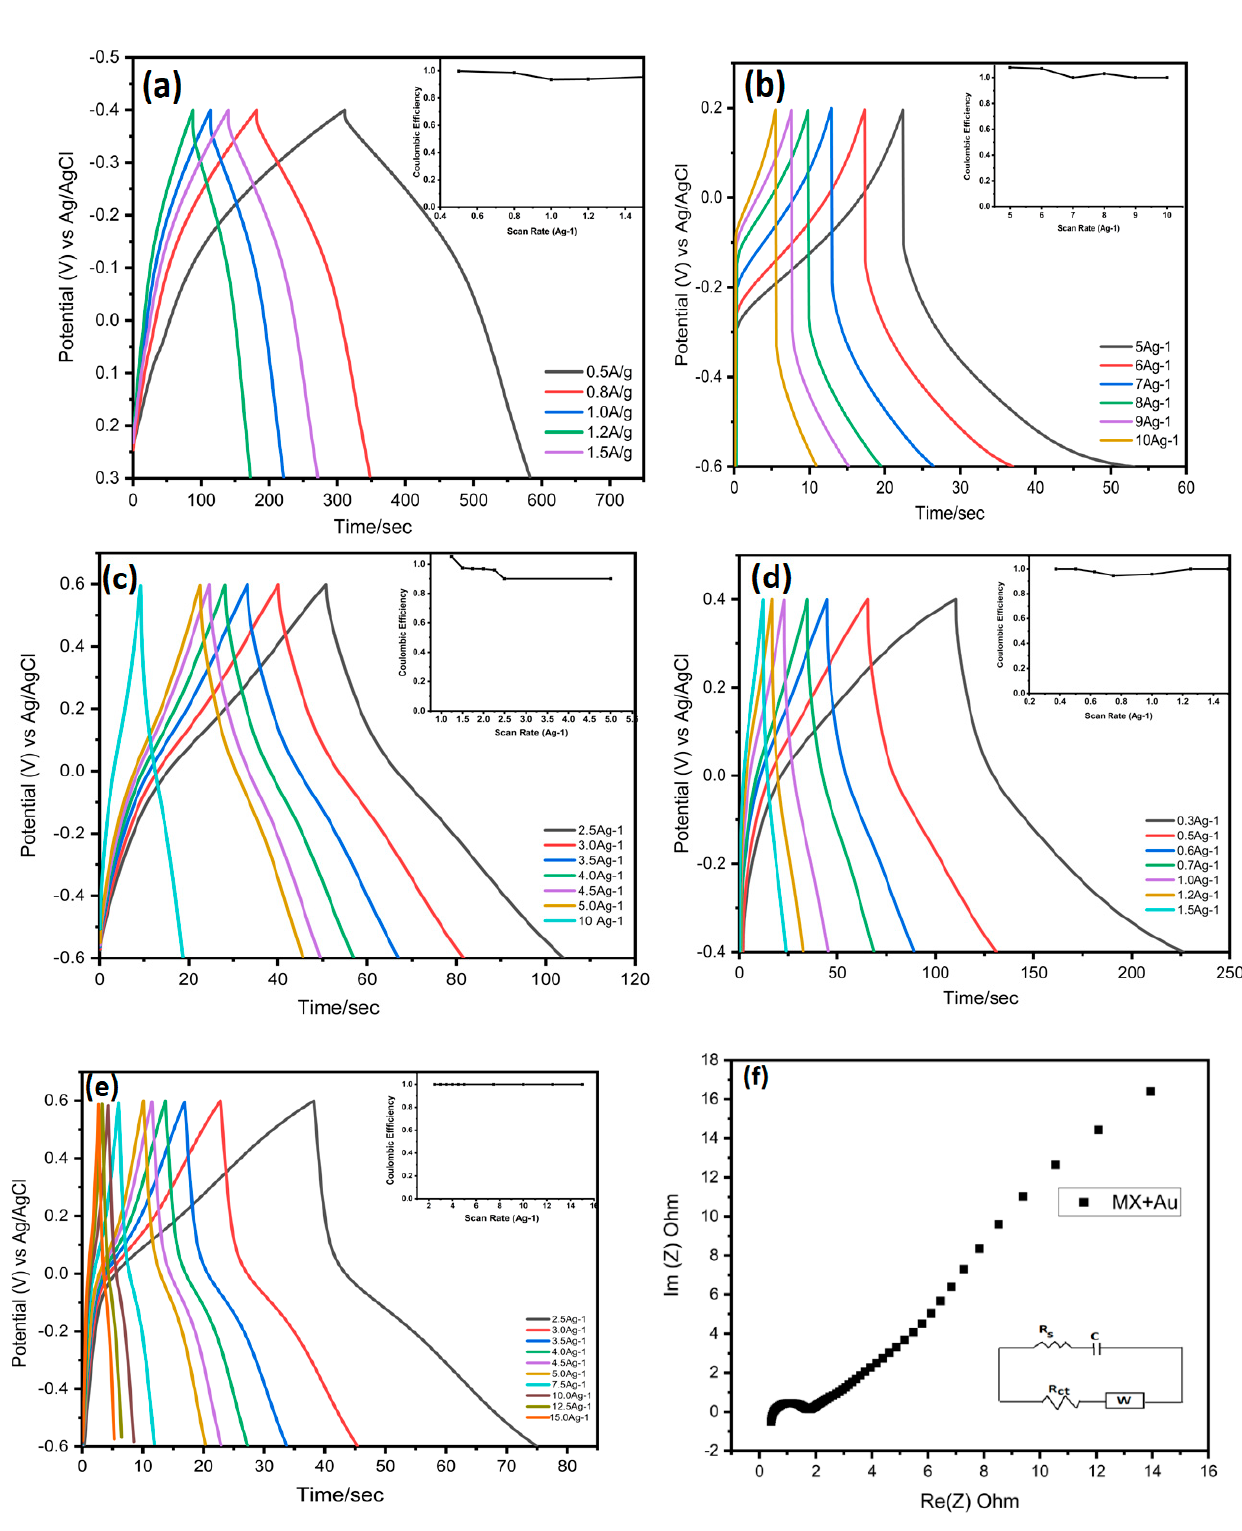
Figure 6. ( a ) GCD curves of MXene with different current densities, in 3-electrode setup, Inset shows the coulombic efficiency; ( b ) GCD curves of MX/AuNPs with different current densities, Inset shows the coulombic efficiency; ( c ) GCD curves of MXene Symmetric SC at different current densities, Inset shows the coulombic efficiency; ( d ) GCD curves of MX/AuNPs Symmetric SC at different current densities 1 M H 2 SO 4 , Inset shows the coulombic efficiency; ( e ) GCD curves of MX/AuNPs Symmetric SC at different current densities 3 M H 2 SO 4 , Inset shows the coulombic efficiency; ( f ) Nyquist plots of symmetric SC of MX/AuNPs and inset shows the equivalent circuit.